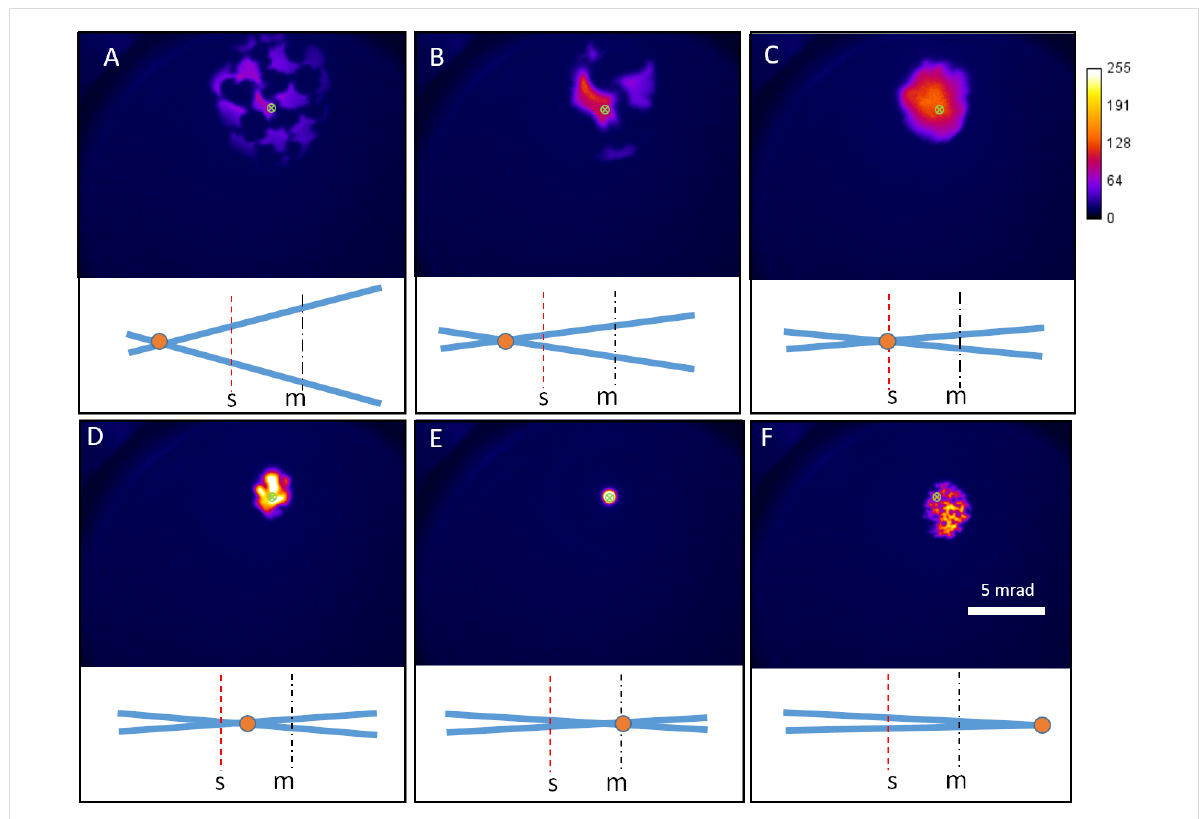
Figure 5: A) A THIM through-focus series of the MgO sample (coated with 10 nm Au on both sides) produced by decreasing the Lens 2 voltage from A to F. No deflection is visible, only inversion of the image occurs close to infinite magnification. Underneath each image is a lens diagram showing the position of the Lens 2 focal point cross over (orange circle), the dashed red line is the sample plane (s) and the dot-dashed black line is the MCP plane (m). The color bar shows the grayscale pixel value recorded in the CCD image. The scale bar in F is 5 mbar and applies to all